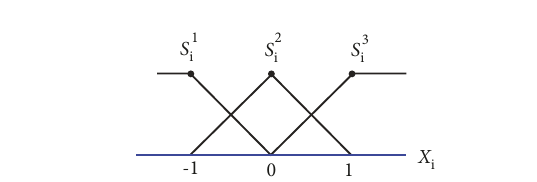
Figure 6: Membership functions of SFS related to system inputs. Table 4: Fuzzy rules of SFSs related to three dynamical variables of the cart.